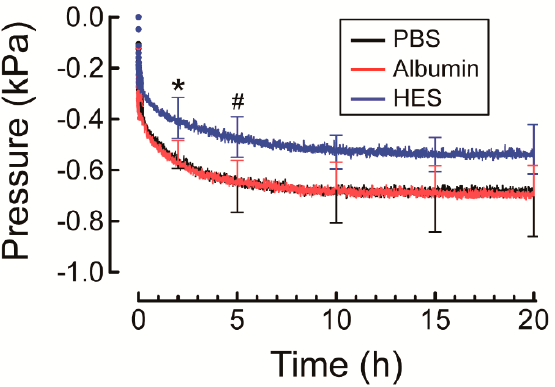
Figure 5. Comparison of changes over time of hydrostatic pressure in the reference chamber of the osmotic flow cell for 1% sodium hyaluronic acid solution (i.e., osmotic swelling pressure) against phosphate buffered saline (PBS), 2% albumin, and 2% hydroxyethyl starch (HES) solution. Experiments were carried out at 25 °C. For simplicity, values are presented as mean and standard deviation for every 5 h ( n = 4). *: significantly different from PBS and albumin at the same time point; #: significantly different from PBS at the same time point.